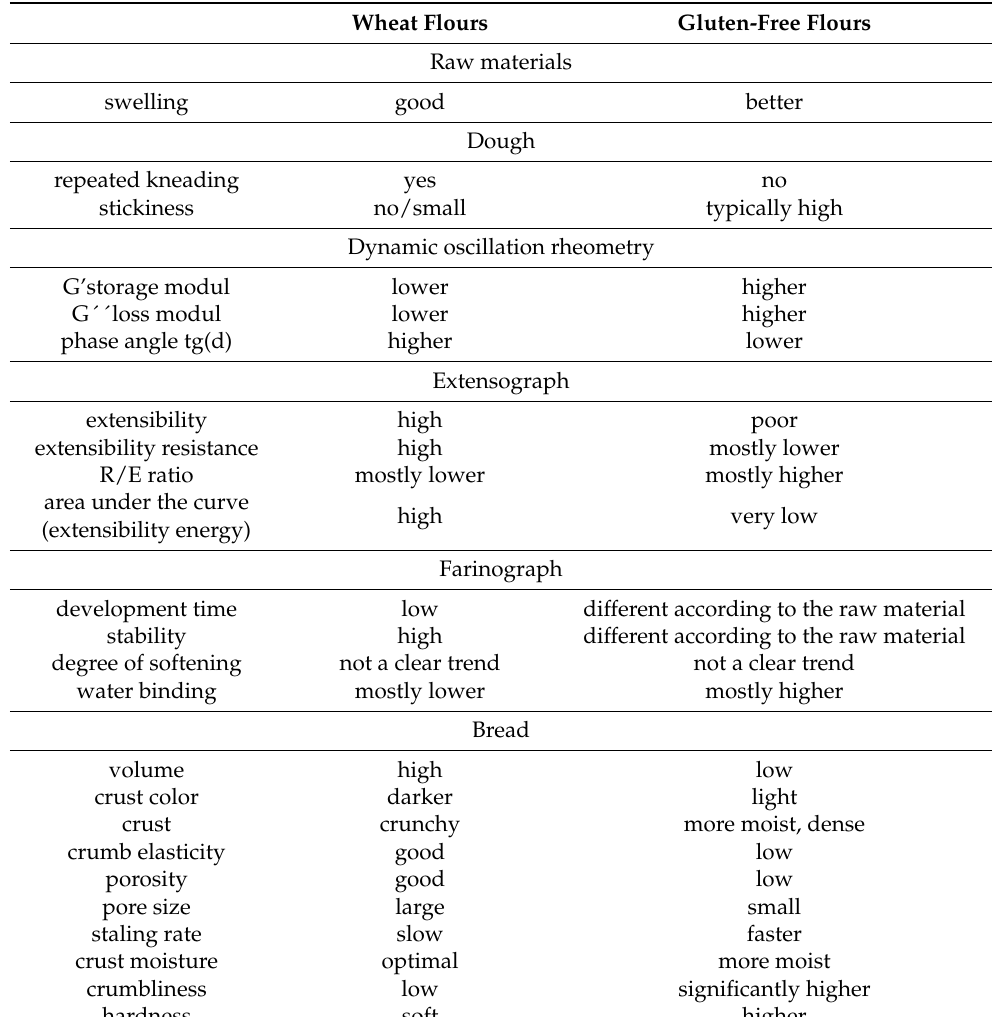
Table 3. The table shows the generalized differences between wheat dough and bread and between gluten-free dough and bread. Adapted and modified according to